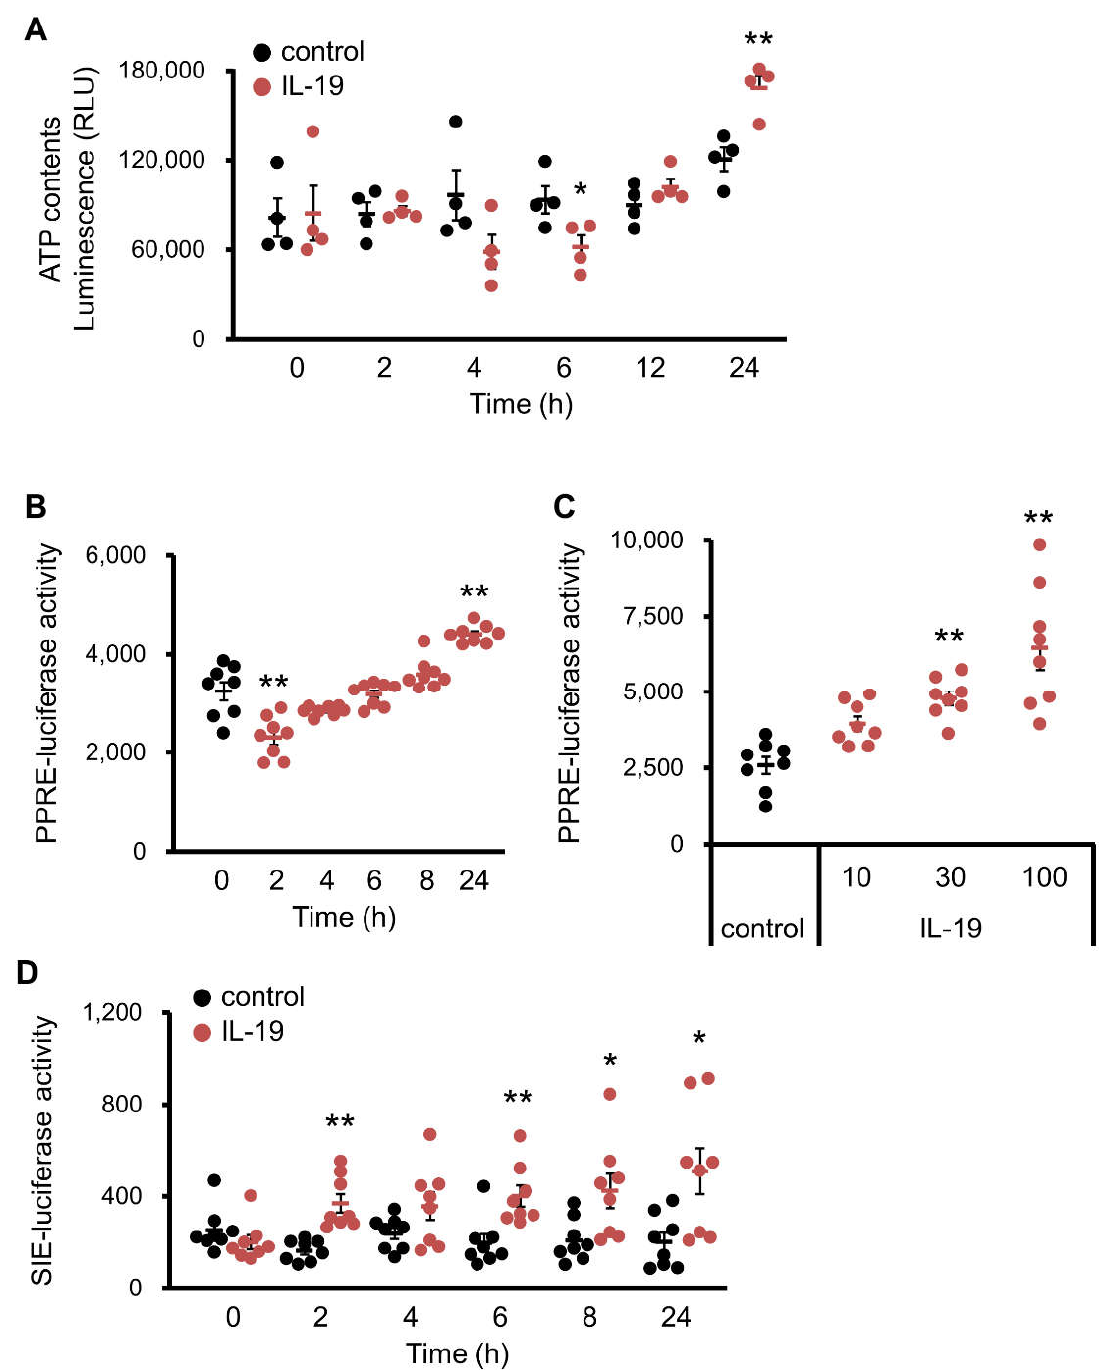
Figure 7. The changes in ATP content and the luciferase activities of PPRE and SIE. ( A ) HepG2 cells were treated with 200 µ M palmitate and 100 ng/mL IL-19. The ATP content was measured ( n = 4). * p < 0.05, ** p < 0.01 vs. control. ( B ) HepG2 cells with expression of PPRE-luciferase were treated with 100 ng/mL IL-19. The luciferase activity was measured ( n = 8). ** p < 0.01 vs. 0 h. ( C ) HepG2 cells with expression of PPRE-luciferase were treated with IL-19 for 24 h. The luciferase activity was measured ( n = 8). ** p < 0.01 vs. control. ( D ) HepG2 cells with expression of SIE-luciferase were treated with 100 ng/mL IL-19. The luciferase activity was measured ( n = 8). * p < 0.05, ** p < 0.01 vs. control.